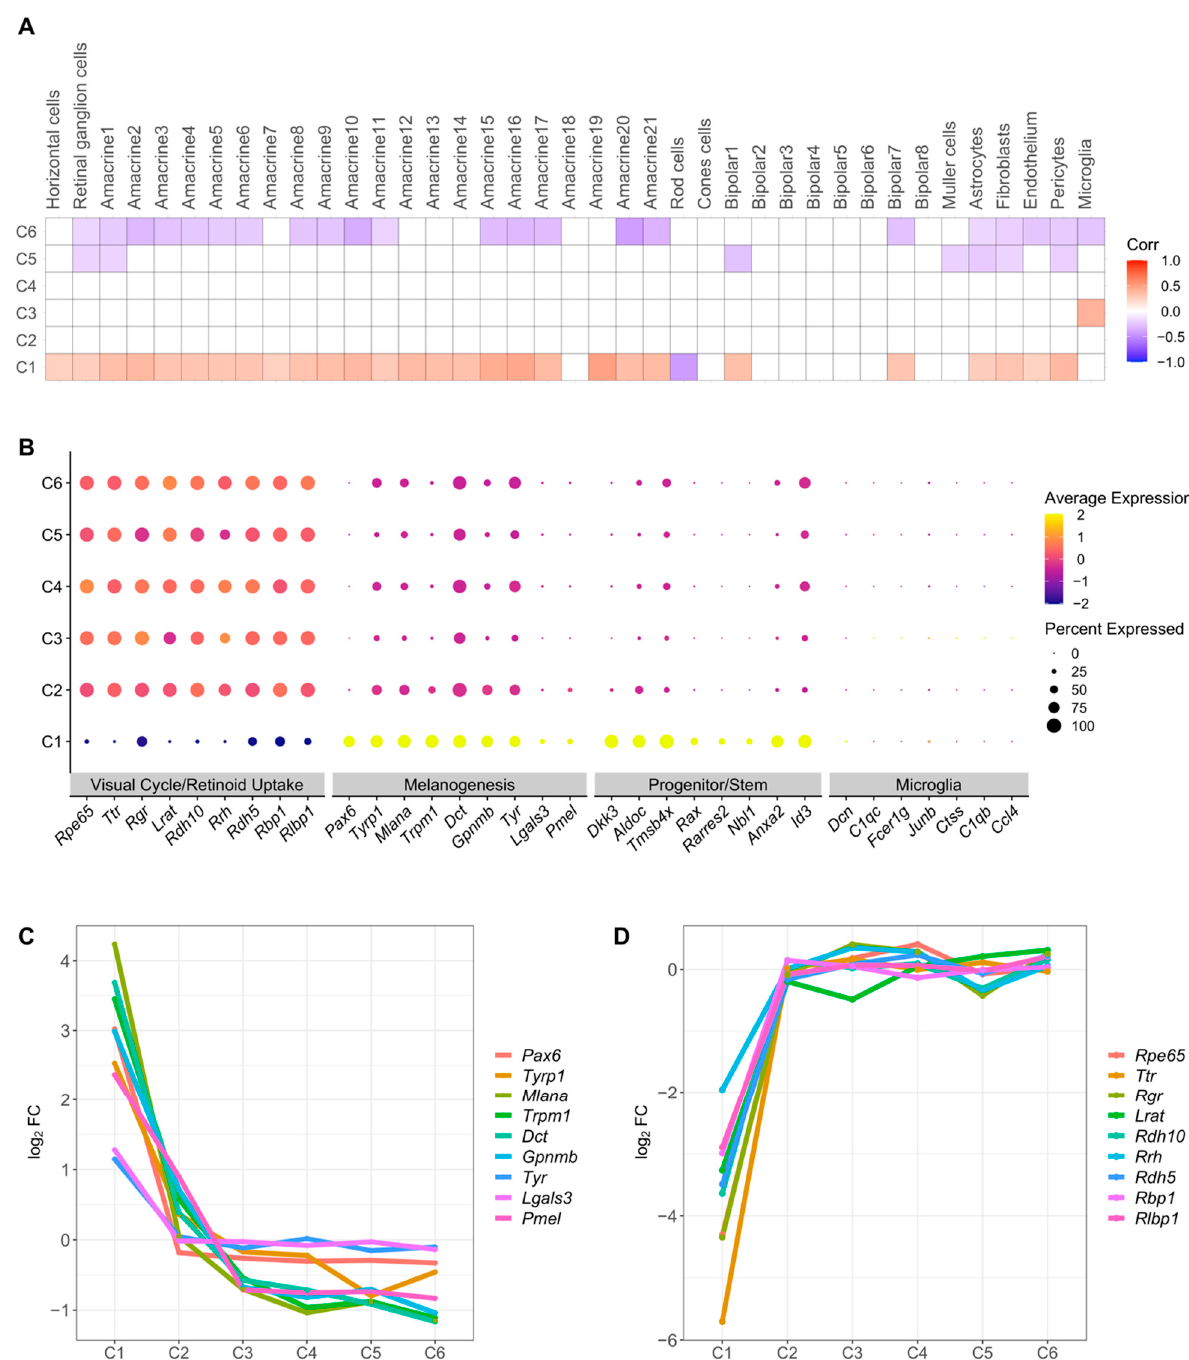
Figure 4. Heterogeneity of RPE cell populations from R1. ( A ) Correlation between single cell clusters in R1 and microglial retinal cell clusters. Pearson correlation coefficients were calculated for log 2 FC of genes in each cluster. Positive correlations are shown in red and negative correlations in blue. Correlation with nominal p -value < 0.05 are considered significant and shown in figure. ( B ) Dot plot showing marker gene expression for different RPE specific pathways (visual cycle, melanogenesis), and cell types (SP cell and immune cells). Dot sizes indicate the percentage of cells in each cluster expressing the gene, and colors indicate average expression levels. ( C ) Differential expression (log 2 FC) of melanogenesis genes along RPE clusters C1–6 ( D ) Differential expression (log 2 FC) of visual cycle genes along RPE clusters